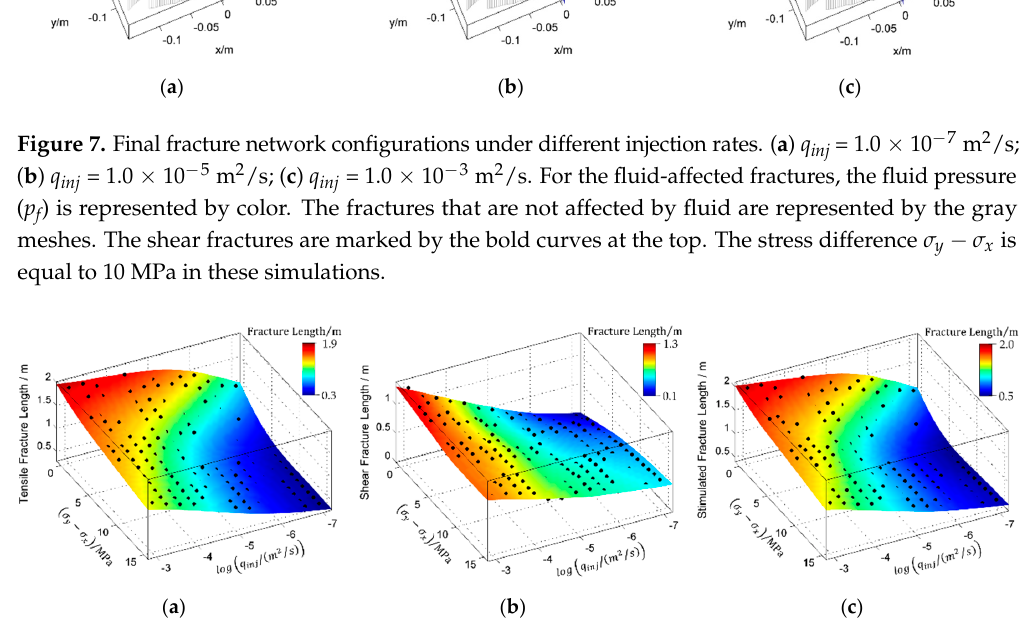
Figure 8. Variations of the fracture lengths with the injection rate and stress difference. ( a ) The variation of the tensile fracture length; ( b ) The variation of the shear fracture length; ( c ) The variation of the stimulated fracture length, i.e., the length of the fractures that are either tensile or shear fractures. In these figures, each black point represents the result of a simulation. The colored surfaces represent the smoothed results.